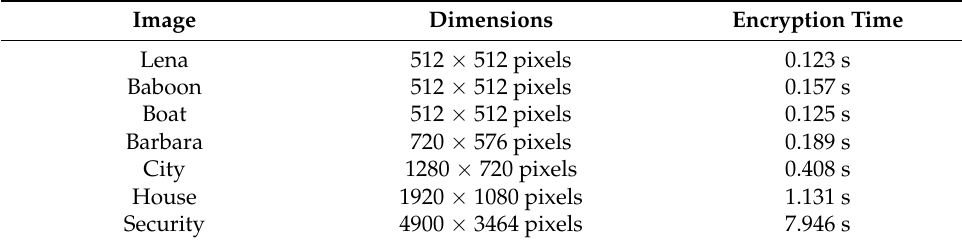
Table 12. Average encryption time measured.